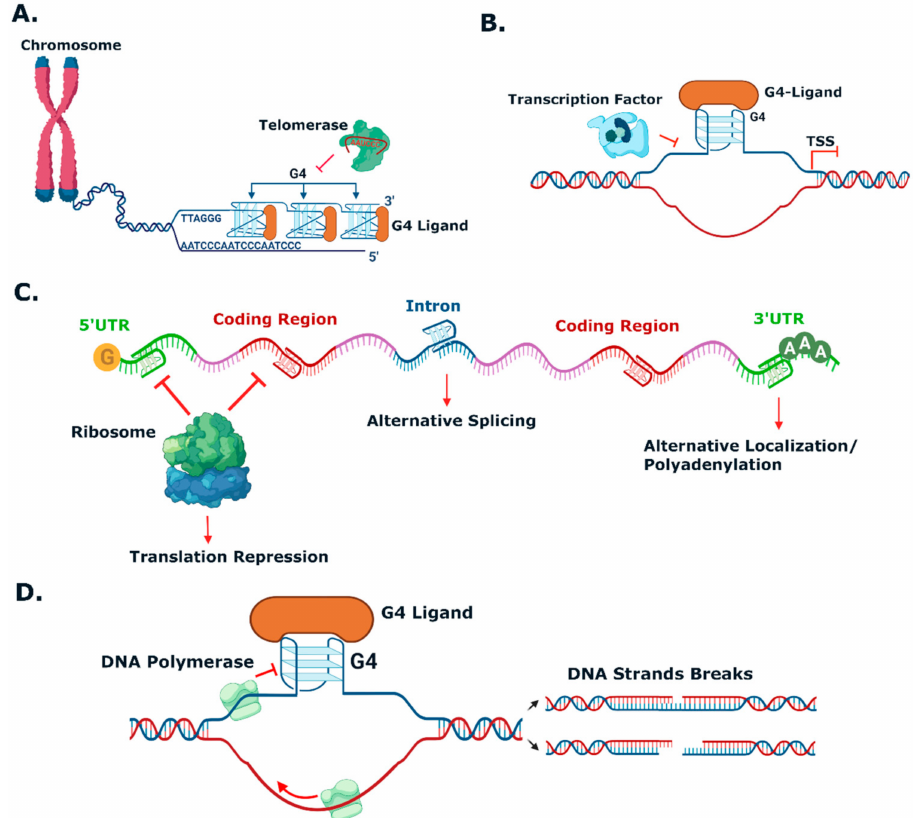
Figure 3. Cellular processes that G4 ligands can target. ( A ) Telomere maintenance. Enriched- guanine telomeres may form G4s at 3 (cid:48) overhang. Telomeric G4 blocks the telomerase and alters the telomere’s elongation and maintenance. ( B ) Oncogene promoter regulation. Formation of G4s within the promoter region usually occurs close to the transcription start site (TSS) and may block transcription factors binding, resulting in downregulation of oncogene expression. ( C ) Translation and mRNA splicing. G4 formation can occur on mRNA strands at different sites causing variations in gene translation. G4s at 5 (cid:48) UTR and coding regions block ribosomal activity leading to translation inhibition; G4s within intron leads to alternative splicing, and G4s at 3 (cid:48) UTR causes translation inhibition and alternative mRNA localization. ( D ) DNA replication. In cell division, the process of DNA replication can be paused due to G4 formation, leading to genomic instability. DNA strand containing G4s will be scanned with gaps by DNA polymerase. These gaps in the new strand lead to DNA double-strand breaks over the following cell division